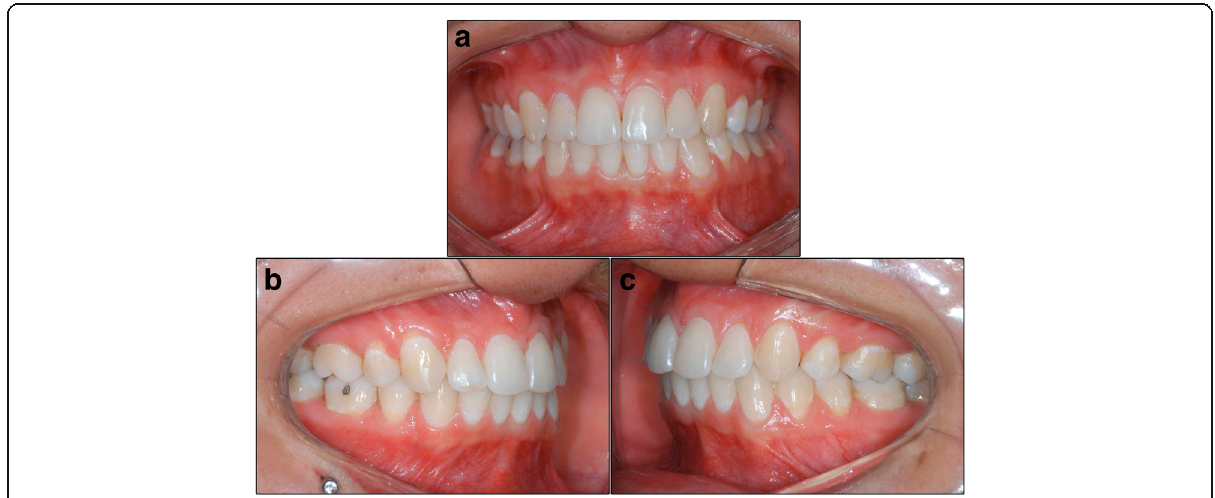
Fig. 1 Group 1 patient – front ( a ), right side ( b ), left side ( c